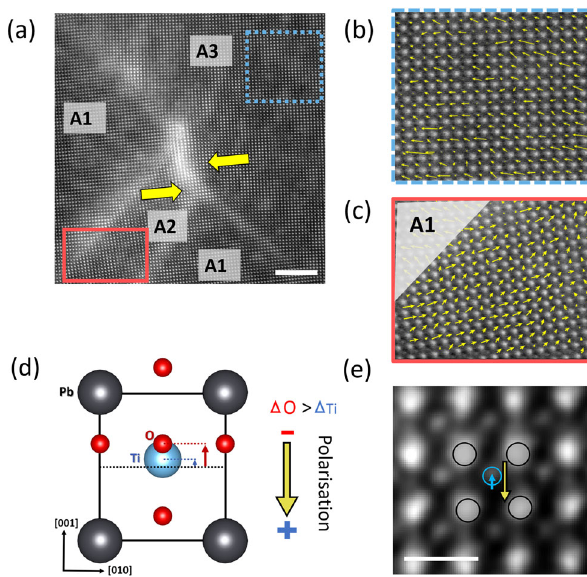
Fig. 3 Polarisation map of domains either side of the charged needle point. a Medium angle annular dark fi eld image of the needle-point domain structure. Boxes indicate the areas of least strain considered in polarisation mapping, and yellow arrows denote the polarisation ( P s ) directions. Scale bar = 5 nm. b , c Unit cell polarisation maps of the highlighted areas in domains A3 (blue, dashed outline) and A2 (red, solid outline), respectively. d , e Schematics showing the unit cell deformation in tetragonal PbTiO 3 and the resulting polarisation in the direction opposite to the Ti shift. Δ O and Δ Ti refer to the displacements of the oxygen and titanium columns from their neutral positions, respectively. Scale bar = 0.5